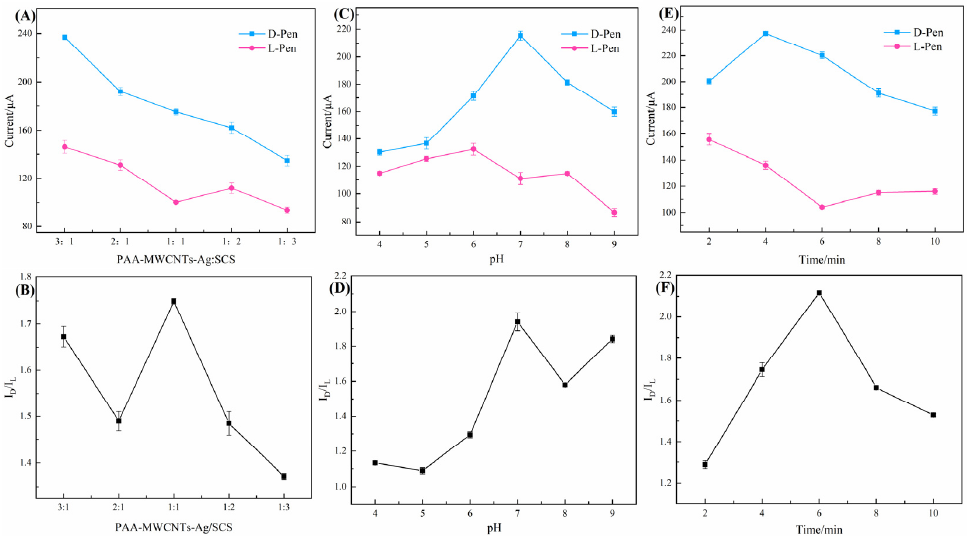
Figure 7. Curves of response current versus each mass concentration ratio ( A ); peak current ratio of the Pen enantiomers at each mass concentration ratio ( B ); curves of response current at each pH ( C ); peak current ratio of the Pen enantiomers at each pH ( D ); curves of response current versus the enantiomeric action time ( E ); peak current ratio of the Pen enantiomers at each action time ( F ).